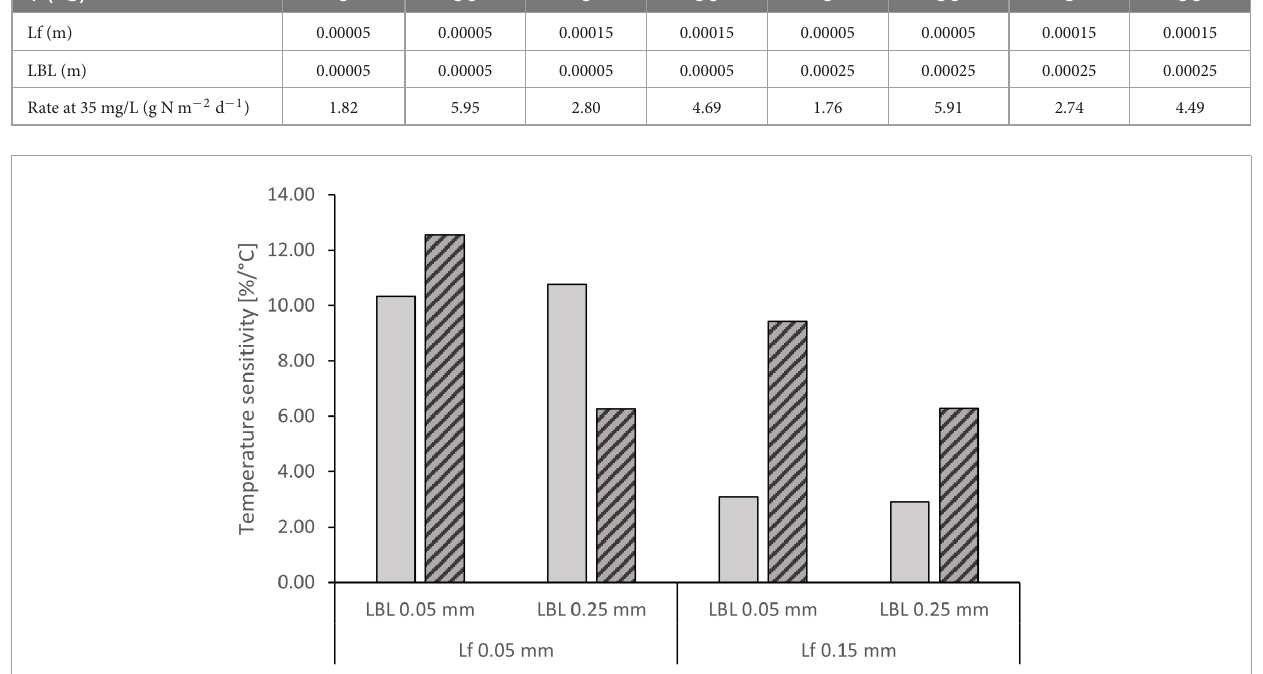
TABLE 3 Model predicted nitrification rates under various combinations of temperature (T), biofilm thickness (Lf), and liquid boundary layer thickness (LBL). T ( ◦ C)